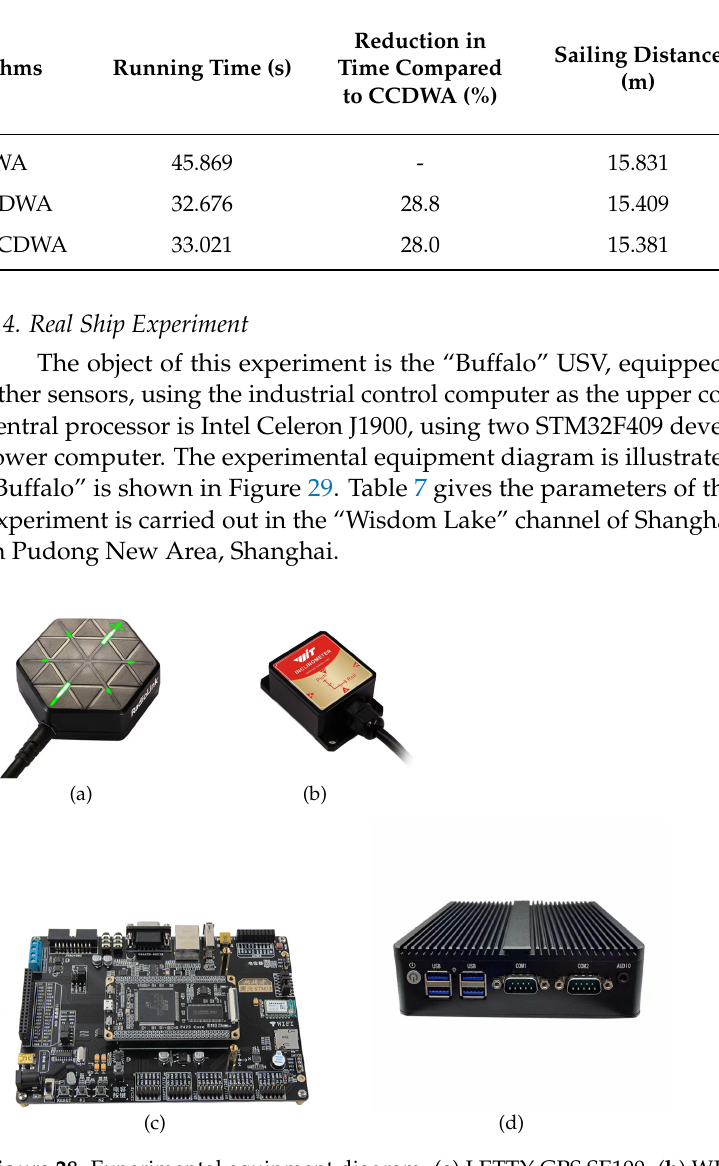
Figure 28. Experimental equipment diagram. ( a ) LETTY GPS:SE100. ( b ) WIT six-axis attitude sensor: